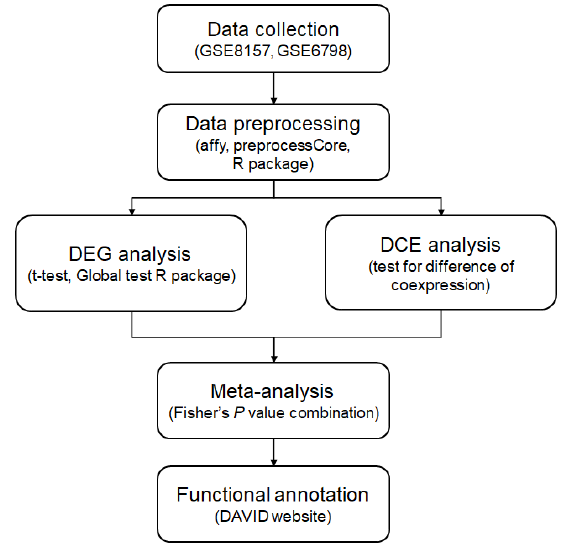
Figure 1. Flowchart of analysis. Two PCOS datasets were collected from the GEO database. After data preprocessing and normalization, differentially expressed gene (DEG) and differentially coexpressed gene (DCE) analysis were performed. Using the p values from the DEG and DCE analysis, a meta-analysis was performed with the p value combination. For identification of biological mechanisms underlying the analysis results, functional annotation was applied.